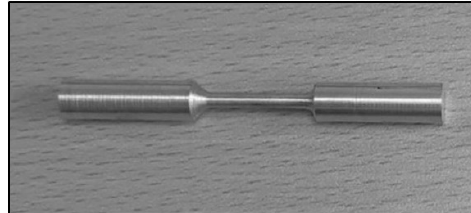
Figure 3. Solid state recycled sample prepared for tensile testing.